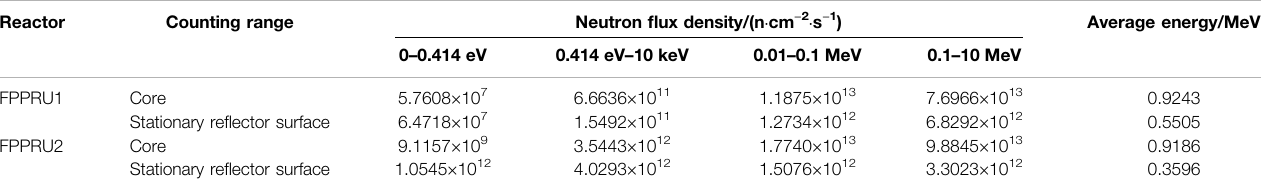
TABLE 2 | Neutron fl ux density and average neutron energy for FPPRU1 and FPPRU2.